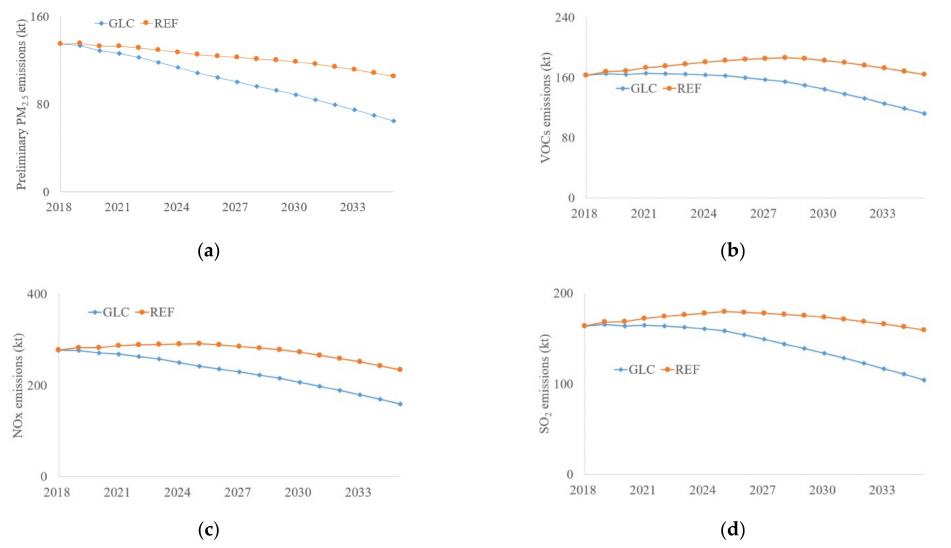
Figure 8. The main air pollutant emissions. ( a ) Preliminary PM 2.5 ; ( b ) VOCs; ( c ) NOx; ( d ) SO 2